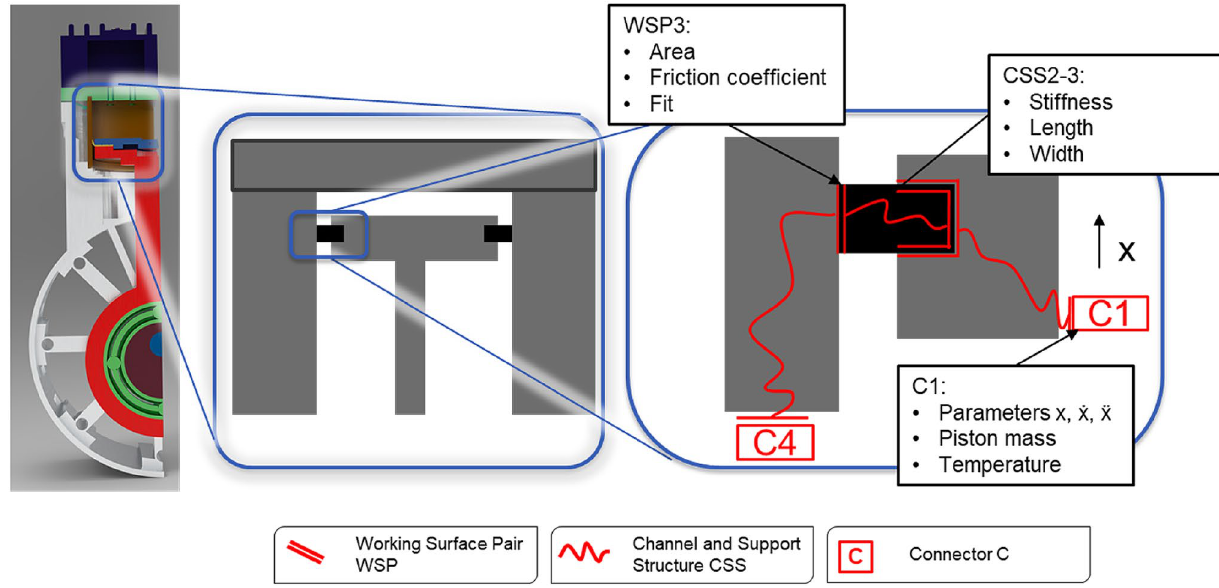
Fig. 12 Fractal modelling with the C&C 2 -Approach at the piston